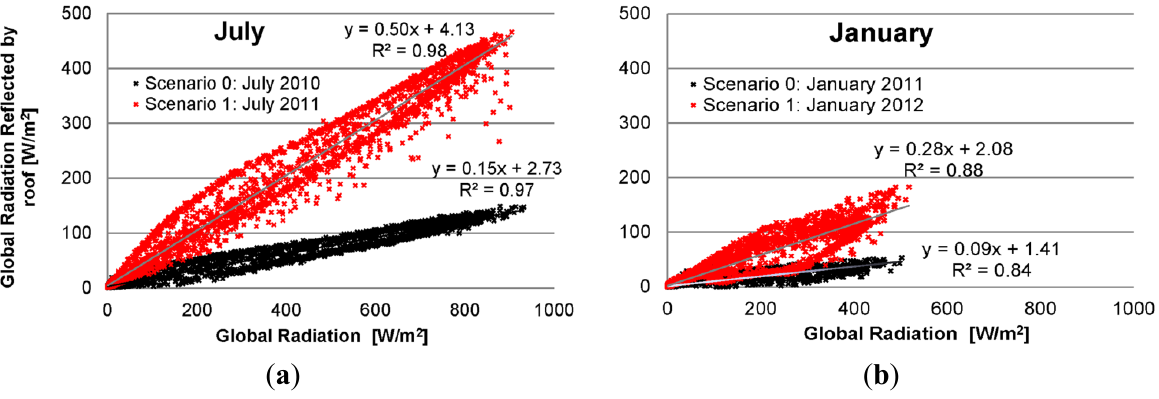
Figure 3. Roof reflectance capability with respect to the global radiation of the location in ( a ) July and ( b )